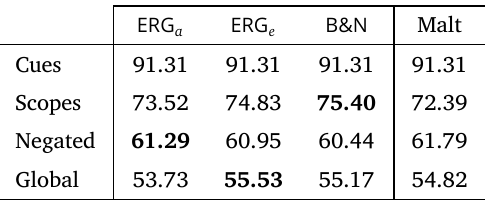
Performance of the negation resolution system on the test set with predicted